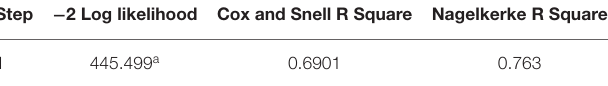
TABLE 10 | Model summary.